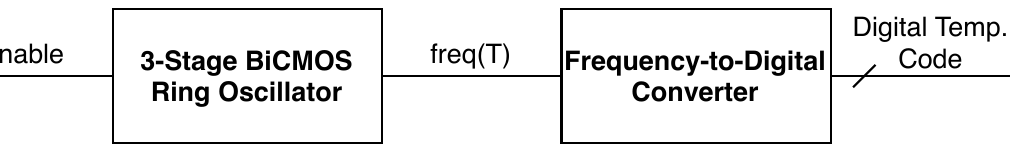
Figure 1. Temperature sensor based on CMOS.